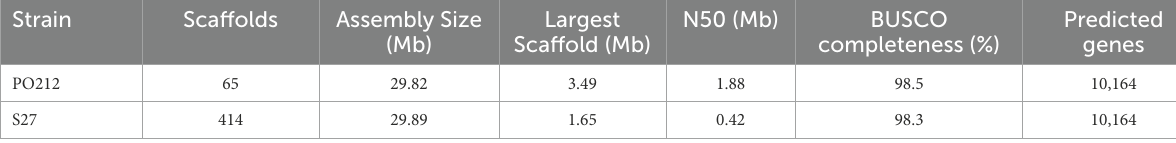
TABLE 4 Assembly and gene prediction summary of PO212 and S27 genomes.